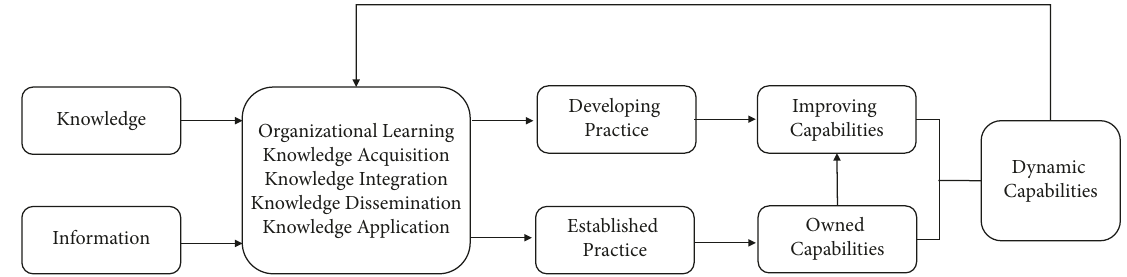
Figure 1: The relationship between dynamic capabilities and organizational knowledge